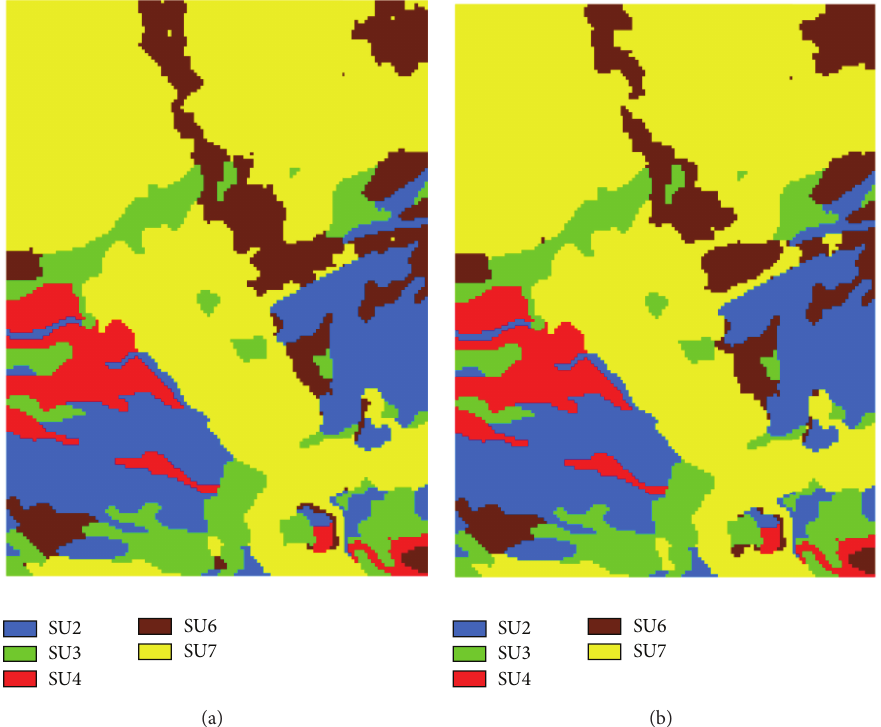
Figure 6: Two simulated realization maps of updated soil series conditioned on sample data and the legacy soil map using the Co-MCSS